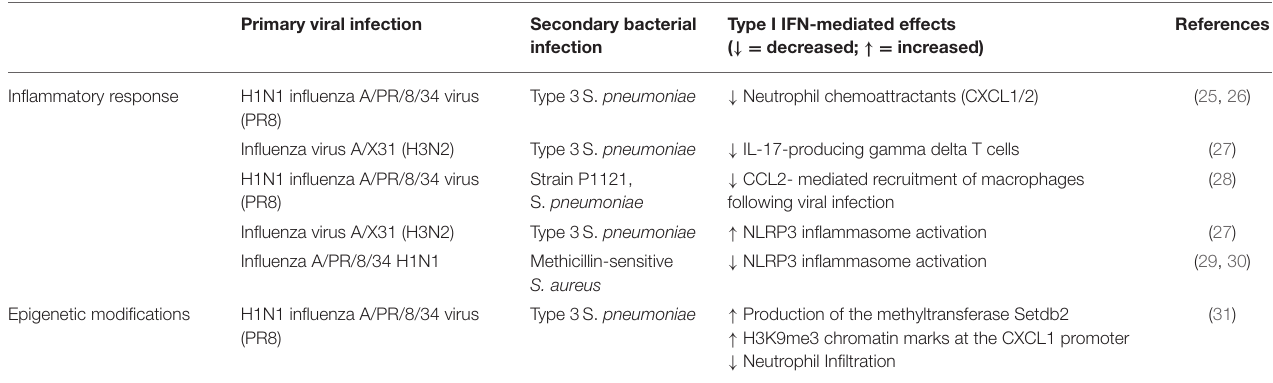
TABLE 1 | The effects of viral—induced type I IFN on the inflammatory response to secondary bacterial infections. Primary viral infection Secondary bacterial Type I IFN-mediated effects infection ( ↓ = decreased; ↑ =